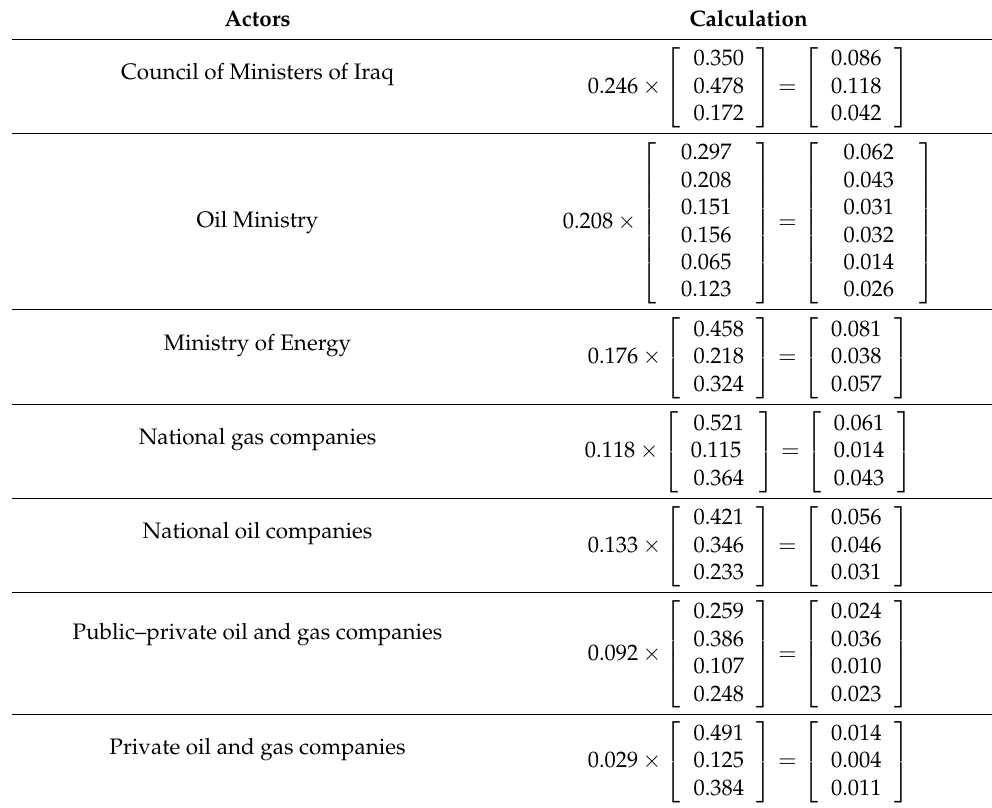
Table 5. Results of the influence of actors on